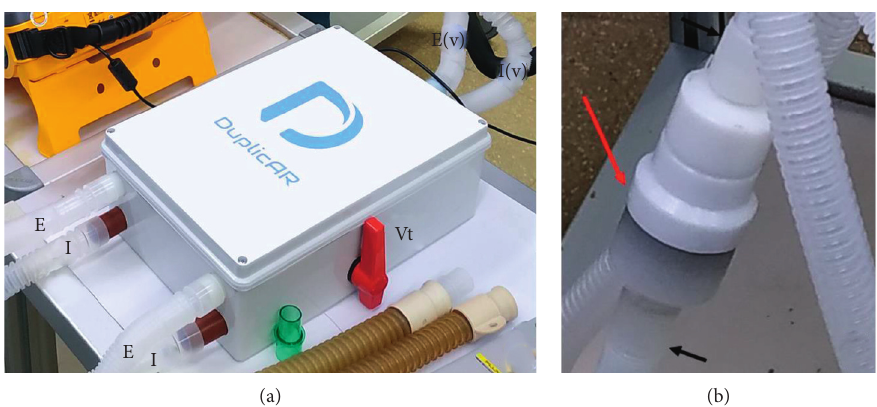
Figure 1: The DuplicAR Ⓡ device: (a) the device with its connections; (b) the PEEP valve controller. E, expiratory limb of each subject; E (v), expiratory limb connected to the ventilator; I, inspiratory limb of each subject; I (v), inspiratory limb connected to the ventilator; Vt, tidal